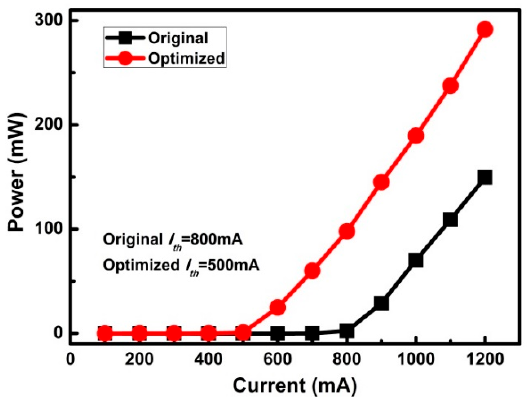
Figure 10. The output light peak power as a function of the pulsed injection current of the original and optimized GaN-based laser diodes.